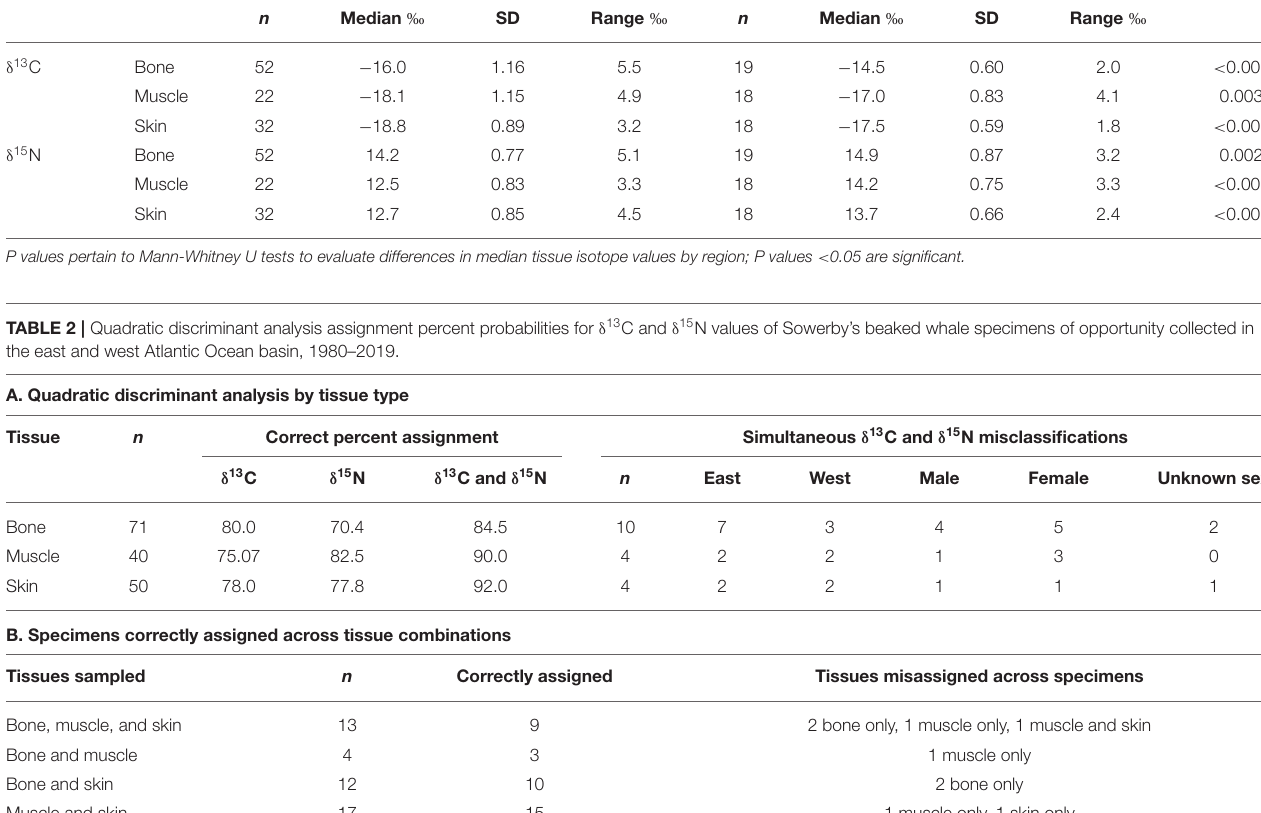
TABLE 1 | δ 13 C and δ 15 N values of Sowerby’s beaked whale specimens of opportunity collected in the east and west Atlantic Ocean basin, 1980–2019. Isotope Tissue